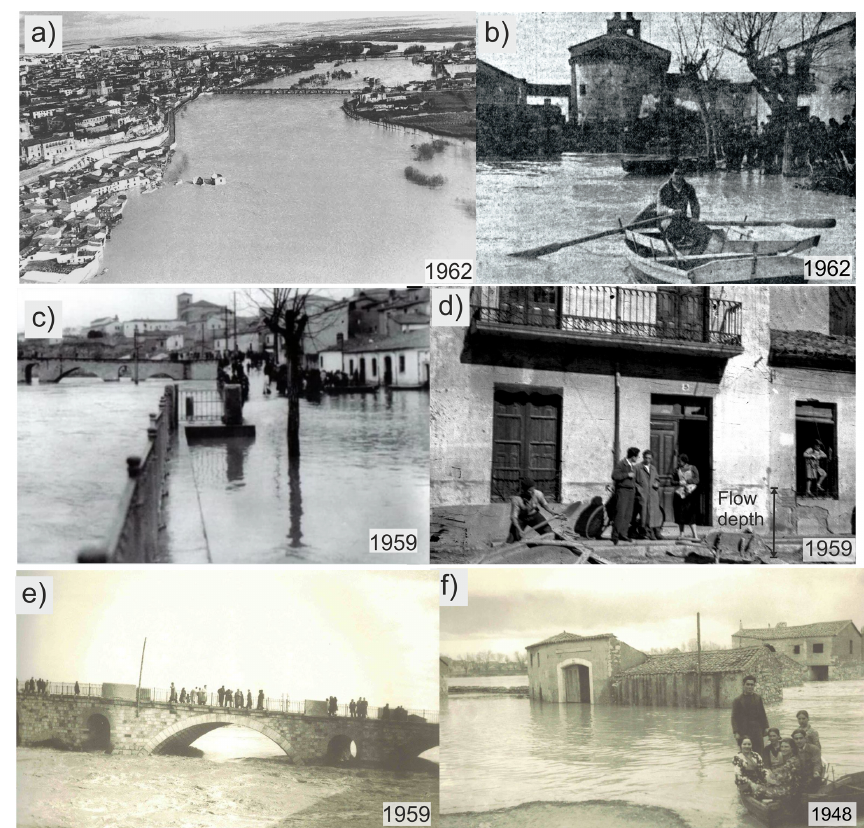
Figure 7. The city of Zamora during flood episodes. (a) Upstream view of the Duero river during the 1962 flood. On the left, the submerged buildings are the Olivares mill and the San Claudio church (source: Archivo Gerardo Pastor Olmedo, vol. III, La Historia Contemporánea). (b) A detailed view of the 1962 flood at San Claudio (background) published by the newspaper Imperio (5 January 1962) (available at https://prensahistorica.mcu.es, last access: 24 November 2021). (c) Horta suburb (Mengue Avenue) and Stone Bridge (background) during the 1959 flood (source: Memoria gráfica de Zamora). (d) Flood level reached by the 1959 flood at La Horta (source: Memoria gráfica de Zamora). (e) The Stone Bridge during the 1959 flood with the water flowing through the bridge spillways (source: Memoria gráfica de Zamora). (f) The Olivares suburb during the 1948 flood (source: Memoria gráfica de Zamora; La Opinión-El Correo de Zamora,